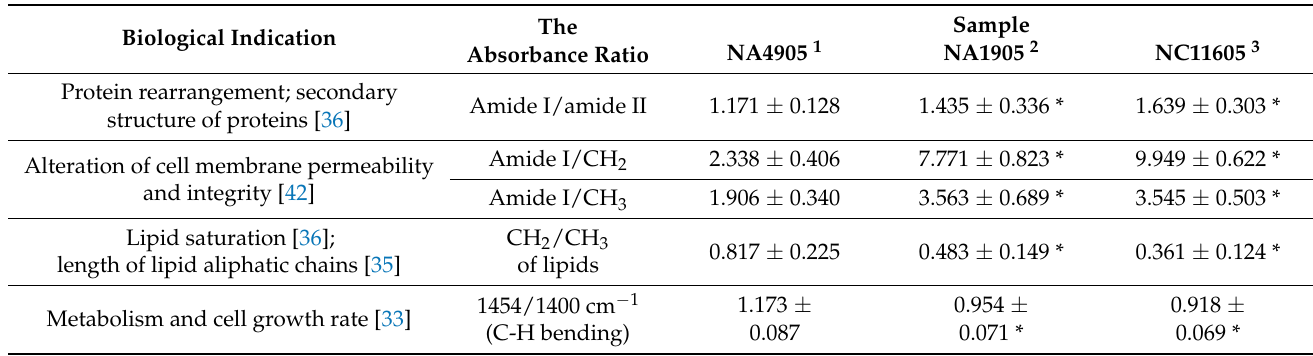
Table 3. The list of the spectral bands absorbance ratios for particular components of trout kidney samples. The results are presented as mean ± standard deviation